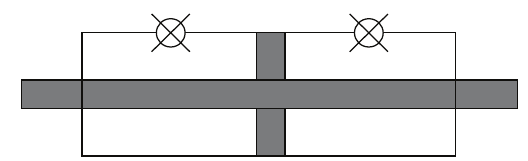
Figure 2: Schematic diagram of hydraulic cylinder-piston system.